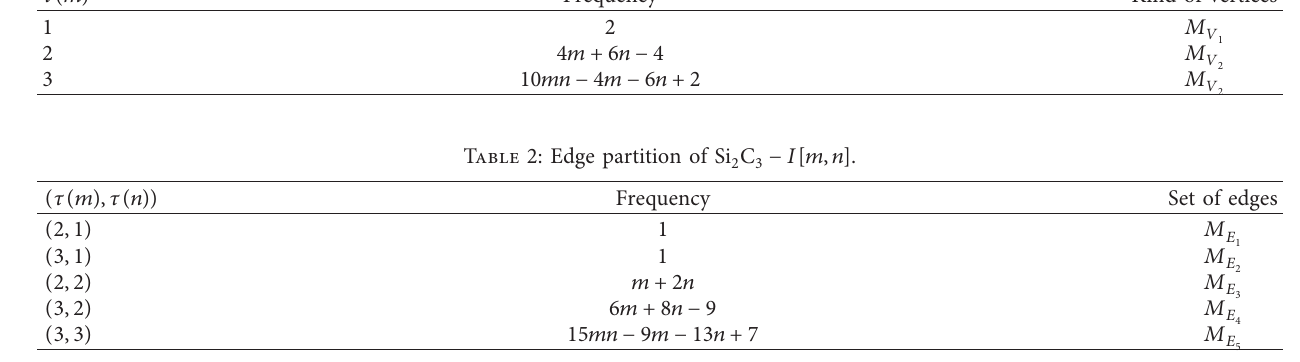
Table 3: Edge partition of Si